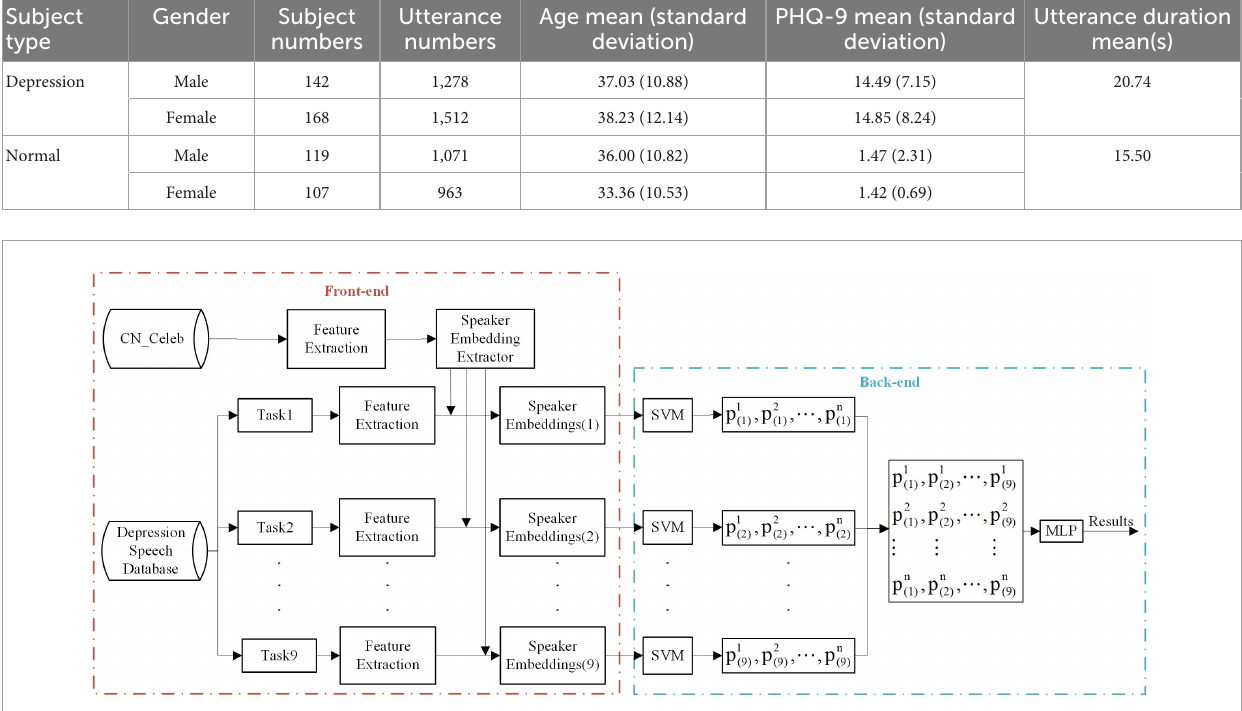
TABLE 2 Details of subjects’ information.